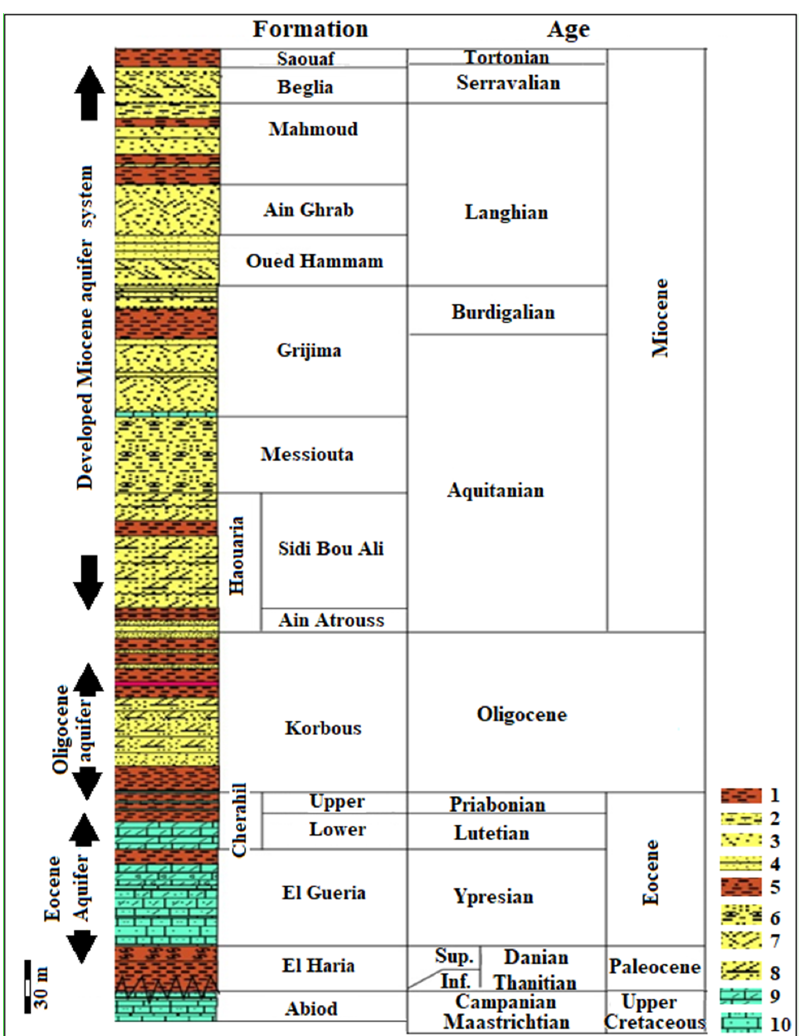
Figure 2. Lithostratigraphic column of the tertiary series in the Ain El Beidha plain (adapted from the J. Touila tertiary series description [17]) and associated hydrogeological systems. (1) Clay. (2) Sandy clay. (3) Sand. (4) Sandstones. (5) Clayey sand. (6) Sand and clay alternances. (7) consolidated and fossilized Sandstones. (8) Siliciclastic deposits. (9) Dolomites. (10) Limestones.